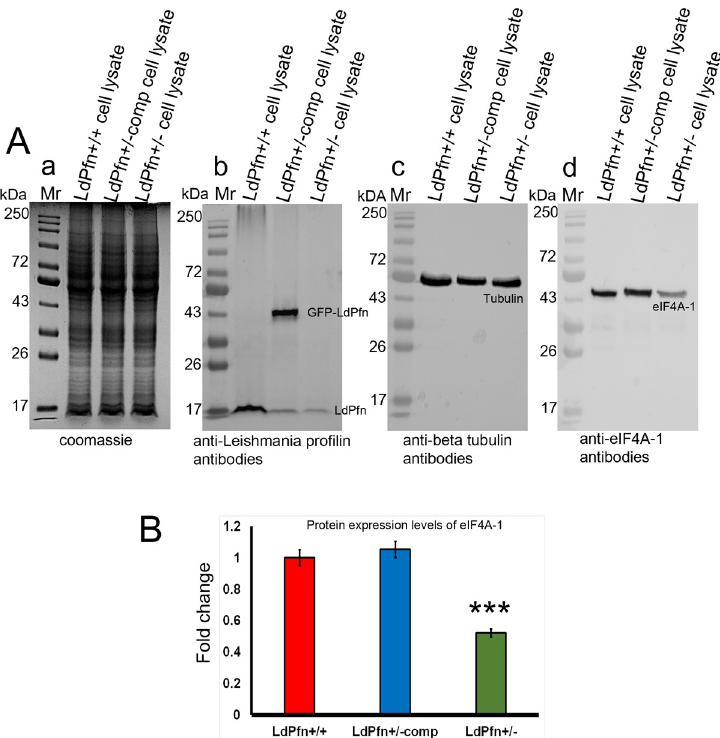
Fig 4. Western blot analysis showing depletion of eIF4A-1 protein in LdPfn +/- cells, compared to LdPfn +/+ and LdPfn +/-comp cells. (A)(a) Coomassie blue-stained 12% SDS-polyacrylamide gel electrophoretogram showing equal loading of total cell lysates of LdPfn +/+ , LdPfn +/-comp and LdPfn +/- cells. Mr, molecular weight markers; lane 1, LdPfn +/ + cell lysate; lane 2, LdPfn +/-comp cell lysate; lane 3, LdPfn +/- cell lysate. (b) Western blot of ‘a’ using anti-LdPfn antibodies. Mr, molecular weight markers; lane 1, LdPfn +/+ cells lysate showing expression of native profilin; lane 2, LdPfn +/-comp cells lysate showing expression of both episomally expressed GFP-LdPfn (43kDa) and native LdPfn (16kDa); lane 3, LdPfn +/- cells lysate showing depletion in the expression of native profilin. (c) Western blot of ‘a’ using anti- β -tubulin antibodies as loading control. Mr, molecular weight markers; lane 1, LdPfn +/+ cells lysate; lane 2, LdPfn +/-comp cells lysate; lane 3, LdPfn +/- cells lysate. For generating LdPfn +/-comp cells, the positive clone of GFP-LdPfn was transfected into LdPfn +/- cells, as described earlier [11]. Hence, there are two bands, one for native LdPfn (16KDa) and other for GFP-LdPfn (43KDa), for profilin in LdPfn +/-comp cells lysate immunoblot. (d) Western blot of ‘a’ using anti-eIF4A-1 antibodies. Mr, molecular weight markers; lane 1, LdPfn +/+ cells lysate; lane 2, LdPfn +/-comp cells lysate; lane 3, LdPfn +/- cells lysate, showing depletion in eIF4A-1 expression levels in LdPfn +/- cells, compared to LdPfn +/+ and LdPfn +/-comp cells. (B) The western blots of three independent experiments have been quantified using GelQuant. net software and the fold change in the protein expression levels of eIF4A1 was calculated by normalizing them against bands of β -tubulin. Around 50% reduction in protein expression levels of eIF4A1 was observed in LdPfn +/- cells, compared to LdPfn +/+ and LdPfn +/-comp